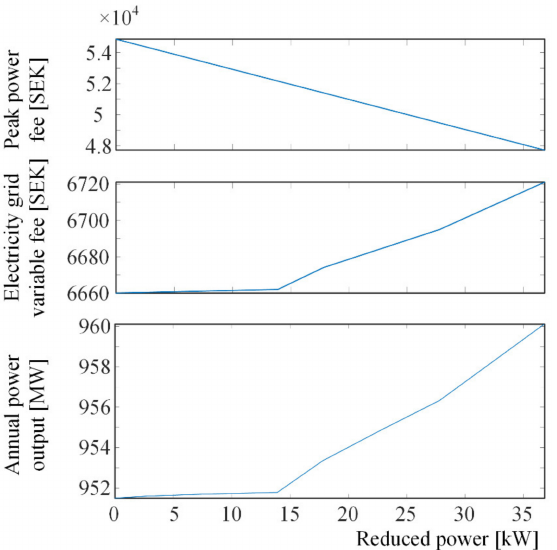
Figure 15. The peak power charge, the variable grid charges, and the annual power output with respect to the reduced power